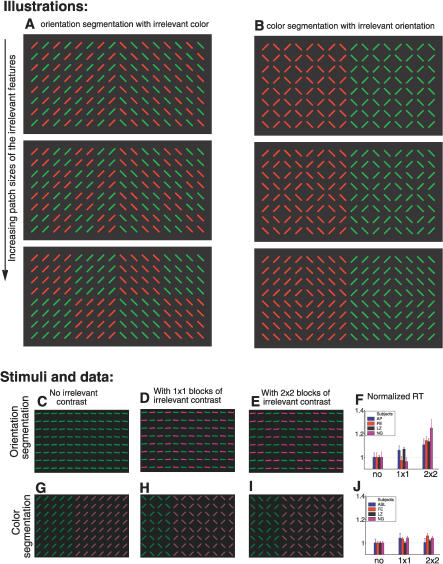
Interference between Orientation and Color, with Schematic Illustrations (Top [A,B]), and Stimuli/Data (Bottom [C–J])(A) Orientation segmentation with irrelevant color.(B) Color segmentation with irrelevant orientation.(A,B) Larger patch sizes of irrelevant color gives stronger interference, but larger patch sizes of irrelevant orientation do not make interference stronger.(C–E) Small portions of the actual experimental stimuli for orientation segmentation, without color contrast (C) or with irrelevant color contrast in 1 × 1 (D) or 2 × 2 (E) blocks. All bars had color saturation suv = 1, and were ±5° from horizontal.(F) Normalized RTs for (C–E) for four subjects (different colors indicate different subjects). The “no”, “1 × 1”, and “2 × 2” on the horizontal axis mark stimulus conditions for (C–E), i.e., with no or n × n blocks of irrelevant features. The RT for condition “2 × 2” is significantly longer (p < 0.05) than that for “no” in all subjects, and than that of “1 × 1” in three out of four subjects. By matched sample t-test across subjects, mean RTs are significantly longer in “2 × 2” than that in “no” (p = 0.008) and than that in “1 × 1” (p = 0.042). Each RT is normalized by dividing by the subject's mean RT for the “no” condition, which for the four subjects (AP, FE, LZ, NG) are 1170, 975, 539, and 1107 ms, respectively.(G–J) Color segmentation, analogous to (C–F), with stimulus bars oriented ±45° and of color saturation suv = 0.5. Matched sample t-test across subjects showed no significant difference between RTs in different conditions. Only two out of four subjects had their RT significantly higher (p < 0.05) in interfering than in no interfering conditions. The un-normalized mean RTs of the four subjects (ASL, FE, LZ, NG) in “no” condition are: 650, 432, 430, 446 ms, respectively.